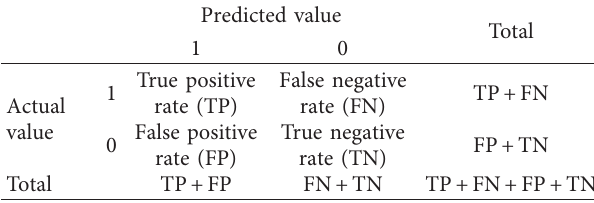
Table 3: Confusion